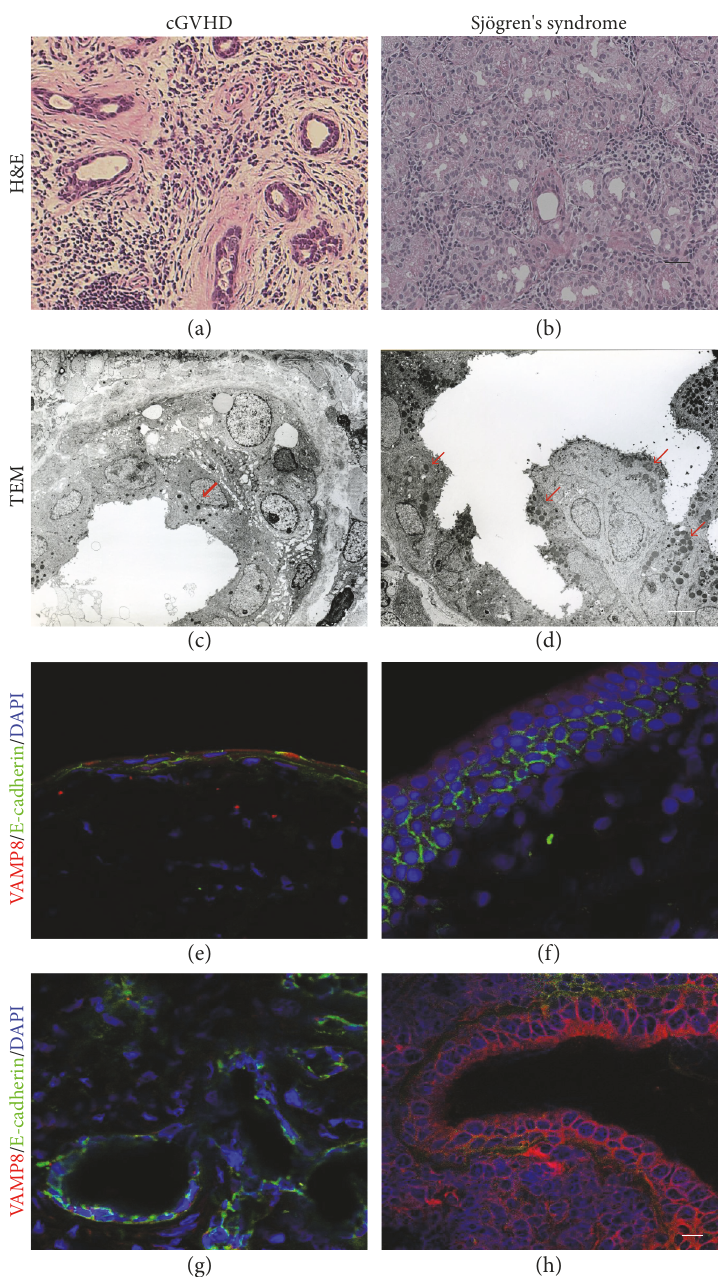
Figure 1: Pathological fi ndings and confocal microscopic images of human cGVHD-a ff ected lacrimal gland and conjunctival epithelia. Hematoxylin & eosin (H&E) staining. GVHD, case 3 (a); Sjögren ’ s syndrome (SS), case 2 (b). Transmission electron microscopic (TEM) fi ndings. GVHD, case 2 (c); SS, case 1 (d). (c, d) Red arrows, secretory vesicle immunostaining for VAMP8 and E-cadherin expression in conjunctival epithelia (e, f) and lacrimal gland (g, h) from cGVHD (case 3) (e, g) and SS (case 2) (f, h) patient. VAMP8 is shown in red, E-cadherin in green, and 4 ′ ,6-diamidino-2-phenylindole (DAPI) in blue. Scale bar =50 μ m (a), 100 μ m (b), 4 μ m (c, d), 25 μ m (e, f), and 20 μ m (g,